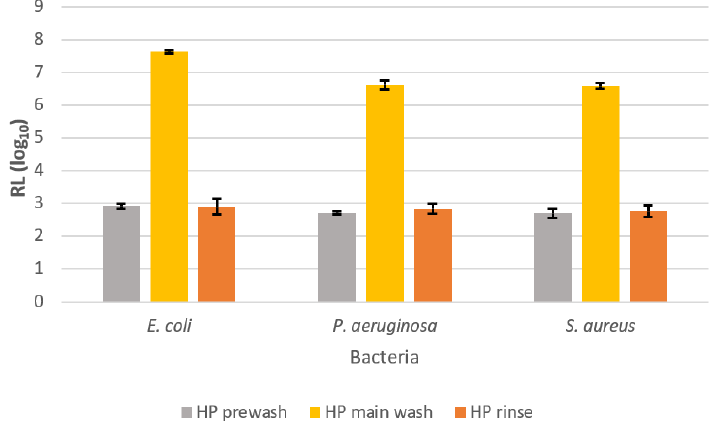
Figure 1. Disinfection activity, RL (log CFU cm − 2 ), of 3% hydrogen peroxide added in the prewash, main wash and rinse cycles against tested bacteria E. coli , P. aeruginosa and S. aureus .